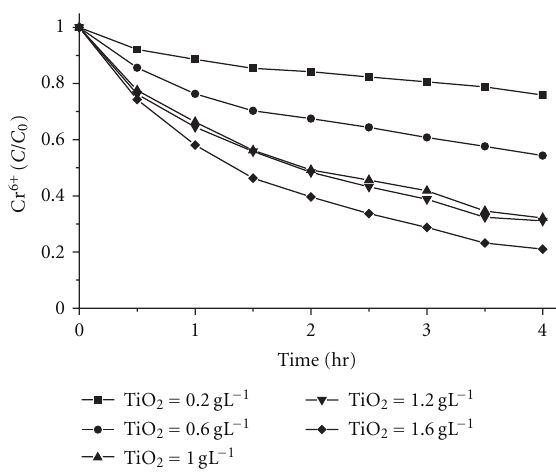
Figure 1: E ff ect of the TiO 2 dosage on the photocatalytic reduction.